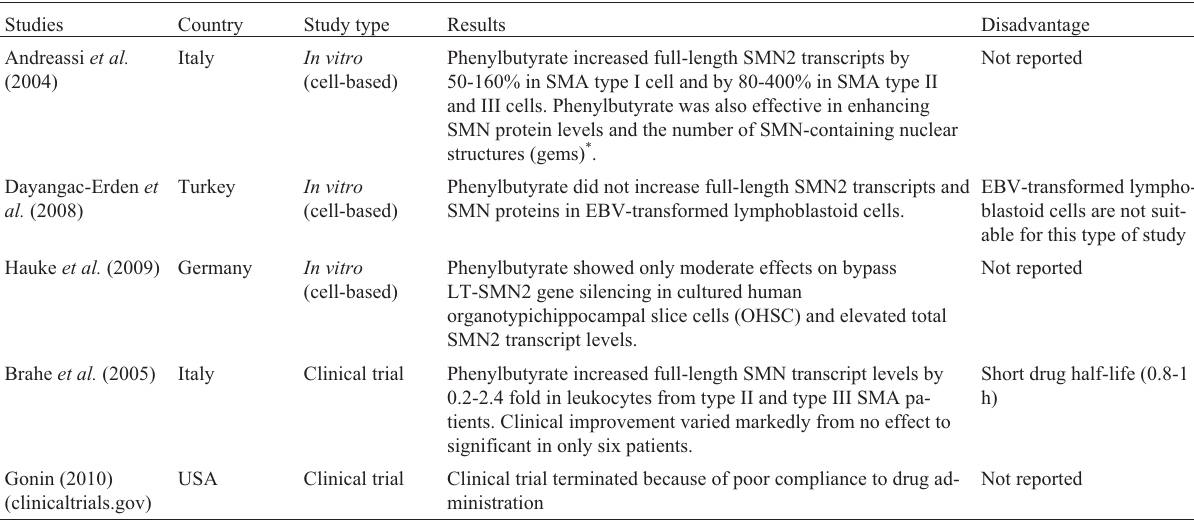
Table 3 - Summary of studies on phenylbutyrate for the treatment of spinal muscular